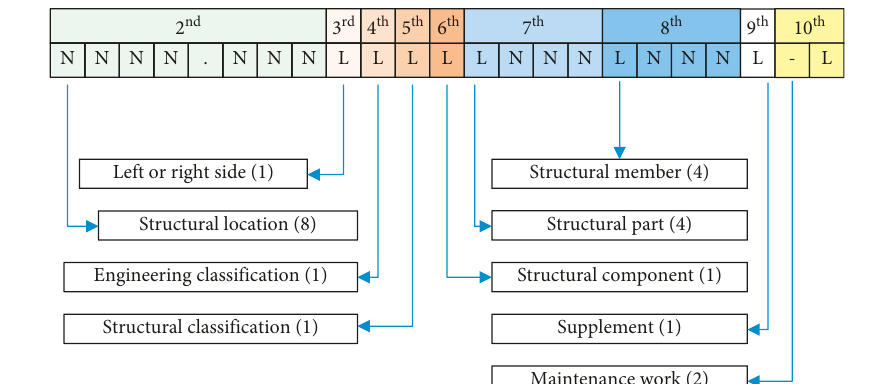
Figure 3: The second classification of EBS coding of a standard structure. Top row 2nd–10th districts are labelled according to letter or number. L refers to abbreviation of “letter” (from A to Z). N refers to abbreviation of “number” (from 0 to 9). The description of breakdown of structure components: structural location, left or right side, engineering classification, and characteristics pertaining to structures.